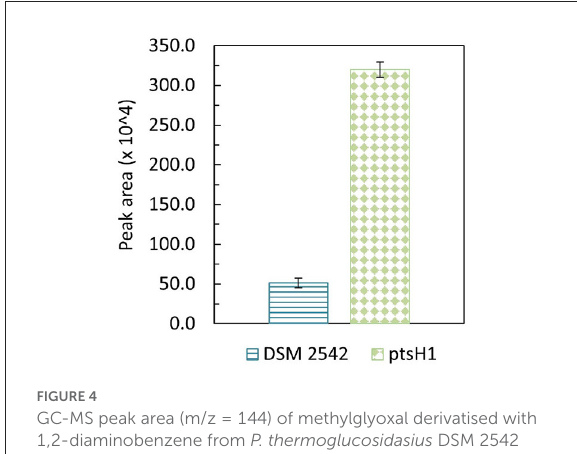
FIGURE4 GC-MS peak area (m/z = 144) of methylglyoxal derivatised with 1,2-diaminobenzene from P. thermoglucosidasius DSM 2542 and DSM2542 ptsH1 cultures after 48-h tube fermentation in ASM medium containing 1% (w/v) glucose and 1% (w/v) xylose. Error bars are standard deviation of three biological replicates. T -test confirmed that the peak areas were statistically different ( p < 0.05).